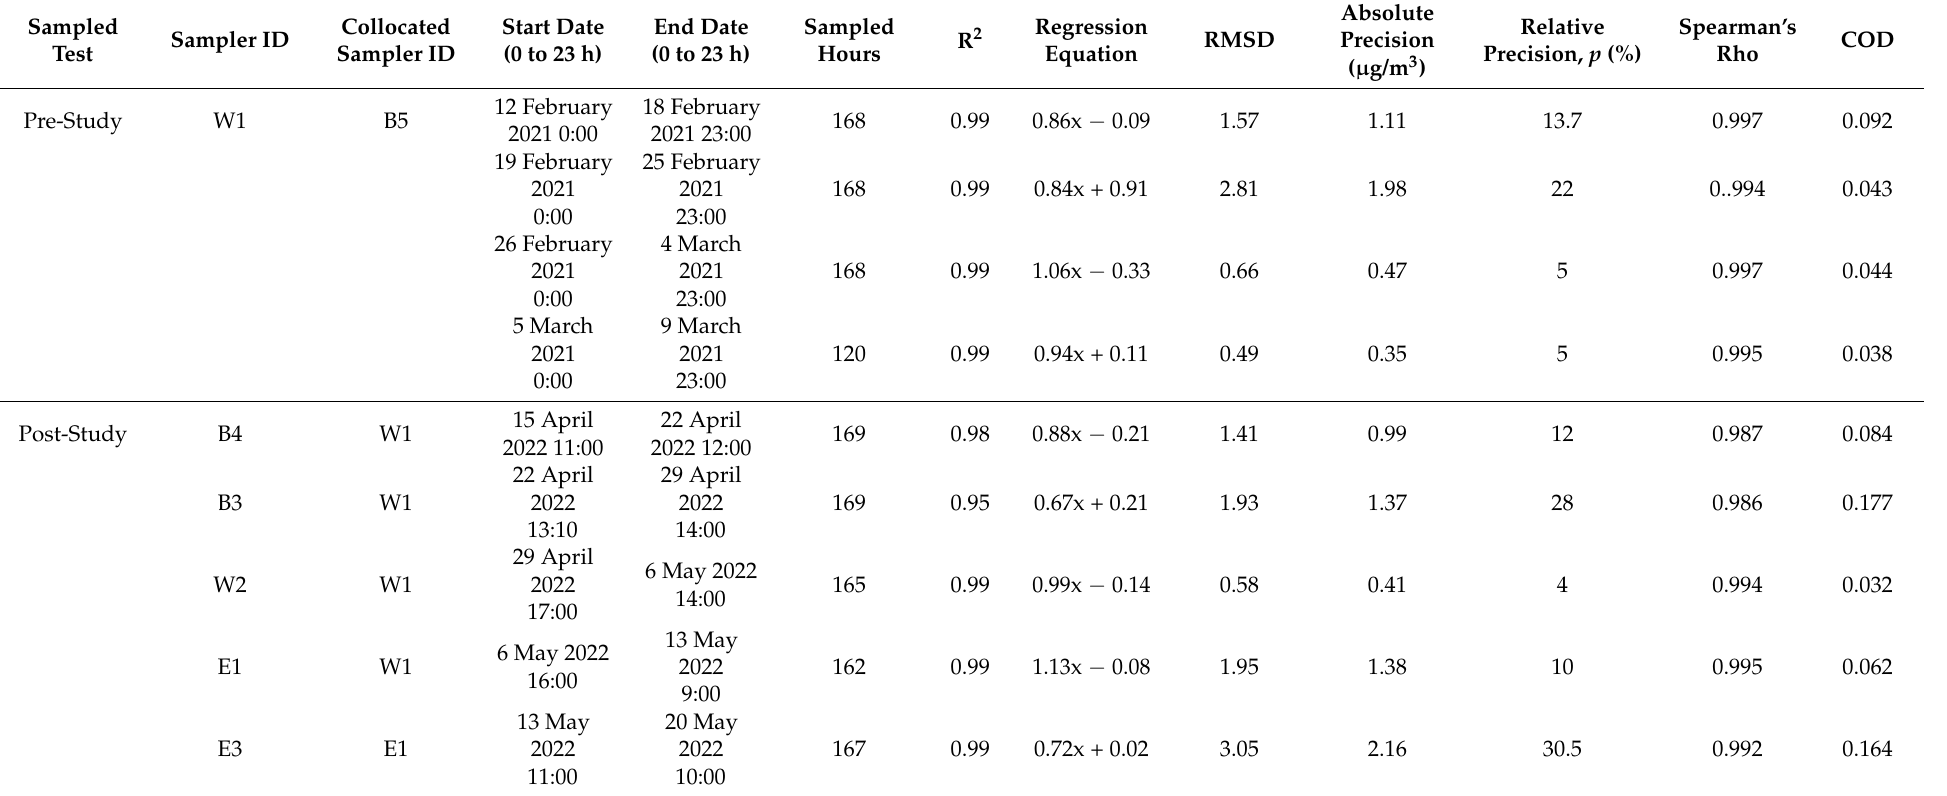
Table 3. Estimates of Coefficient of Determination (R 2 ), RMSD, Absolute and Relative Precision for the